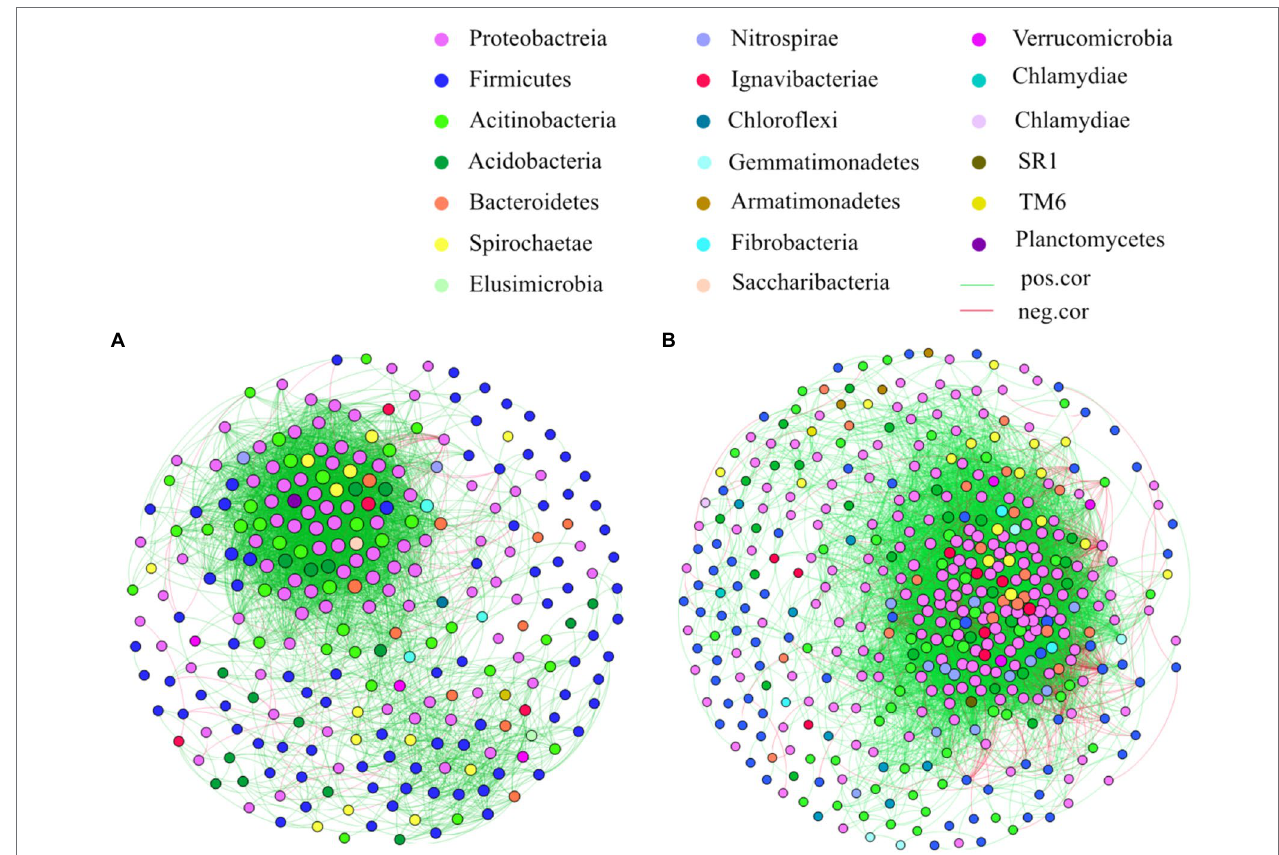
FIGURE 3 | Co-occurrence network diagrams of samples at the vegetative (A) and reproductive (B) stages. Connections stand for Spearman’s correlation with r > 0.75 and statistical significance at p < 0.01. Nodes are colored by taxonomy, and the size of each node is proportional to the number of connections (i.e., degree). Green and red lines represent co-occurrence and mutual exclusion, respectively. Details regarding the co-occurrence network are reported in Supplementary Tables 5, 6